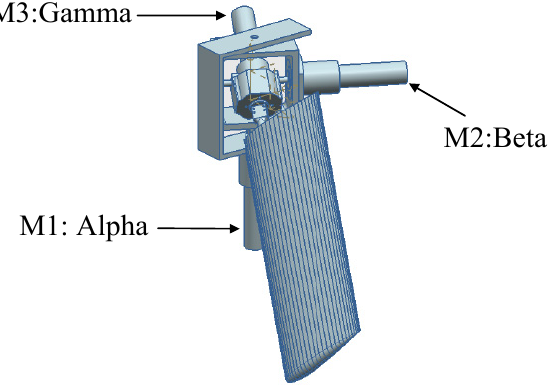
Figure 6. Representation of the hydrofoil and propulsion mechanism. The three motors used are also labeled.